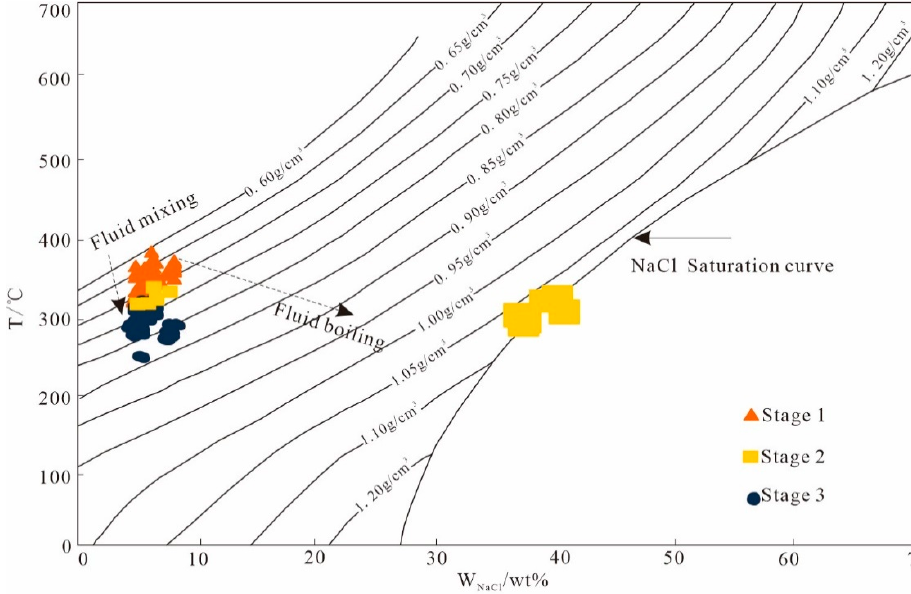
Figure 8. W(NaCleqv)-T(°C) phase diagram of fluid inclusions in the Reshui Mo deposit.